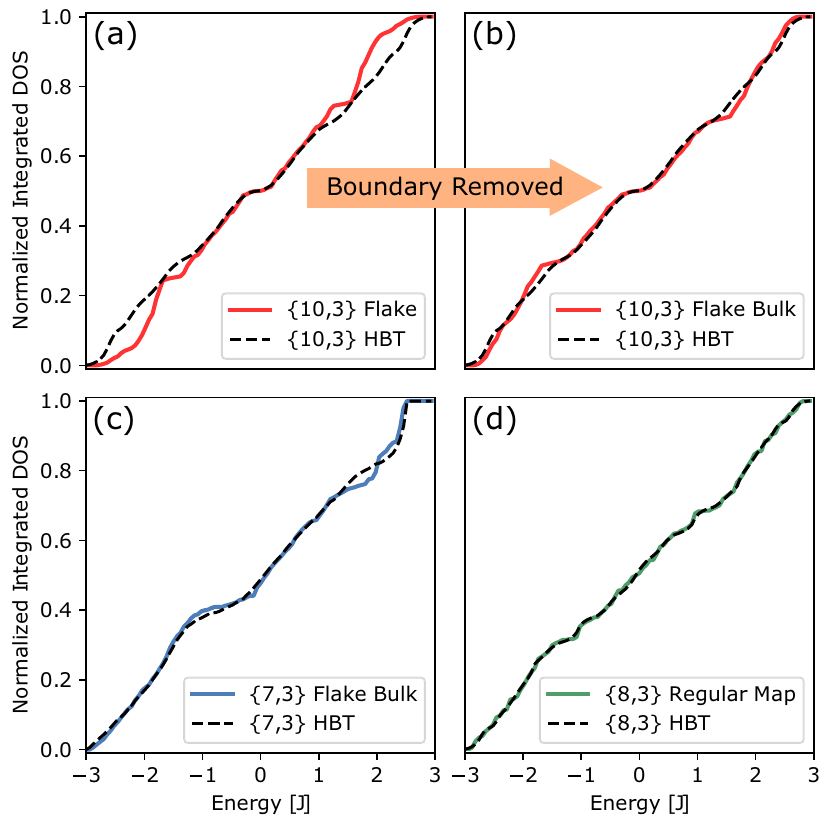
Fig. 3 | Density of states. Integrated DOS computed from fi nite { p , 3} lattices vs. predictions from hyperbolic band theory (HBT) realizedin unit-cell circuits. a DOS of a {10, 3} fl ake with 2880 sites. b Bulk-DOS of the same lattice as in a . With the